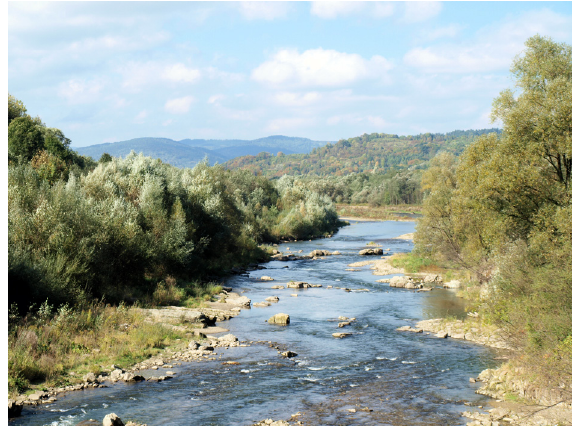
Fig. 6. The fragment of the rocky channel in the Skawa river. Photo: K.